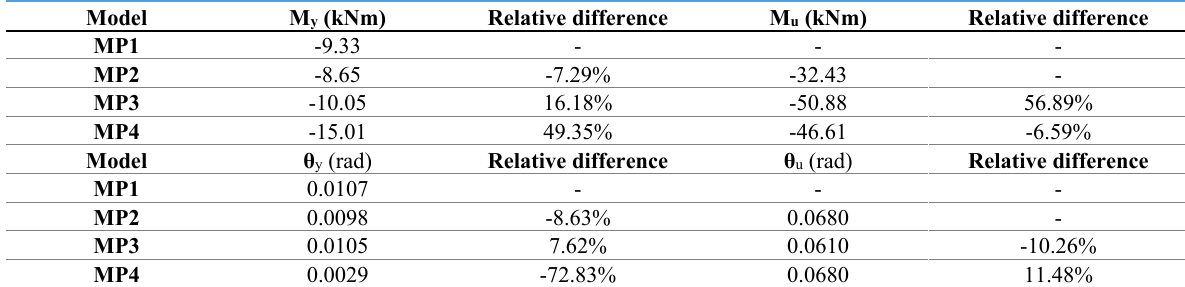
Table 6. Model moments and